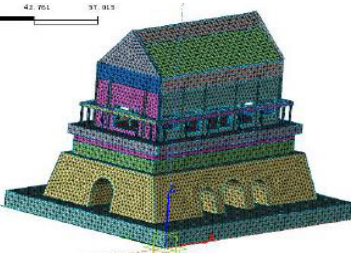
Figure 13. Overall model mesh